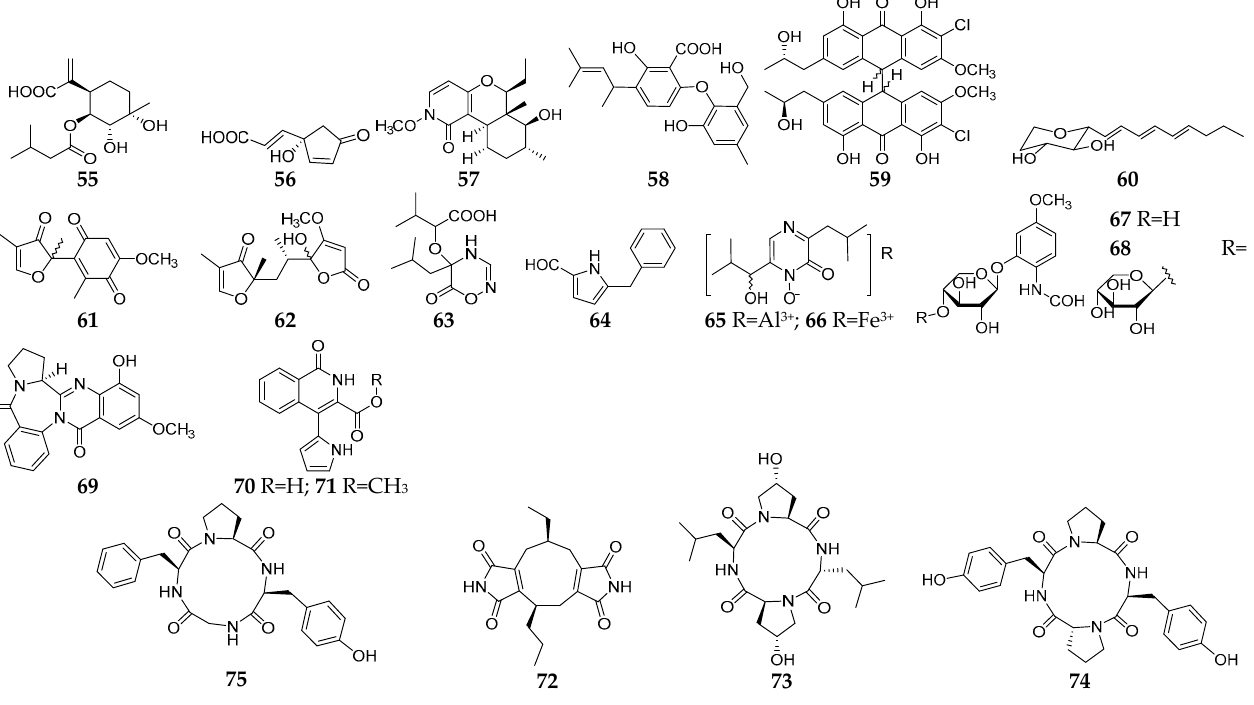
Figure 3. New SMs ( 55 – 75 ) isolated from fungal–fungal co-cultures using other liquid medium. Sclerotiorumins A–C ( 61 – 63 ) together with one pyrrole derivative 1-(4-benzyl-1H- pyrrol-3-yl) ethanone ( 64 ) and two metallo-organic complexes ( 65 and 66 ) were synthesized by two marine-derived fungi A. sclerotiorum and P. citrinum in the co-culture liquid medium which consisted of glucose, soluble starch, MgSO 4 , KH 2 PO 4 , peptone, and sea salt [51]. When strains Trametes versicolor and Ganoderma applanatum co-cultured in a medium containing glucose (10 g/L), KH 2 PO 4 (1 g/L), MgSO 4 (0.5 g/L), and peptone (2 g/L) , two